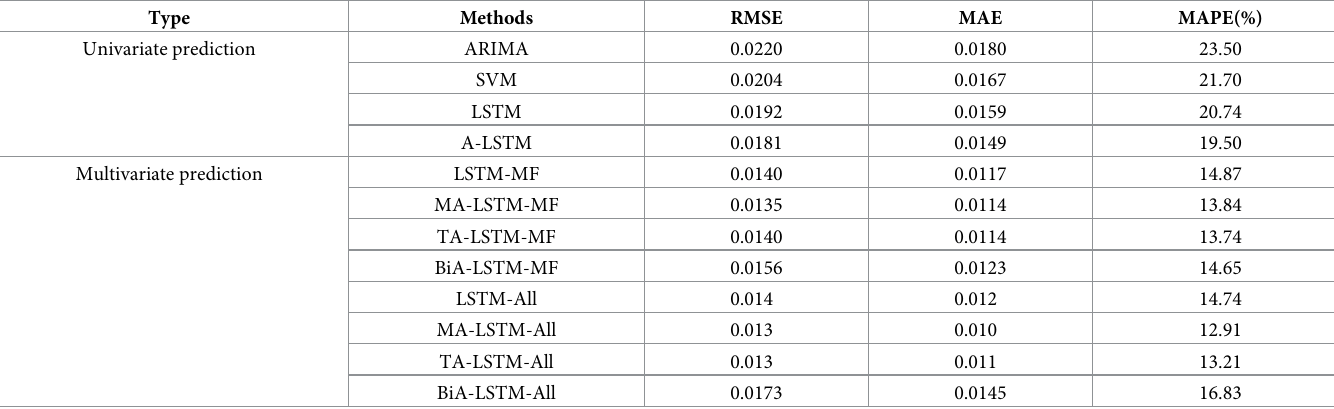
Table 1. Prediction results of hepatitis E incidence by all the models. Type